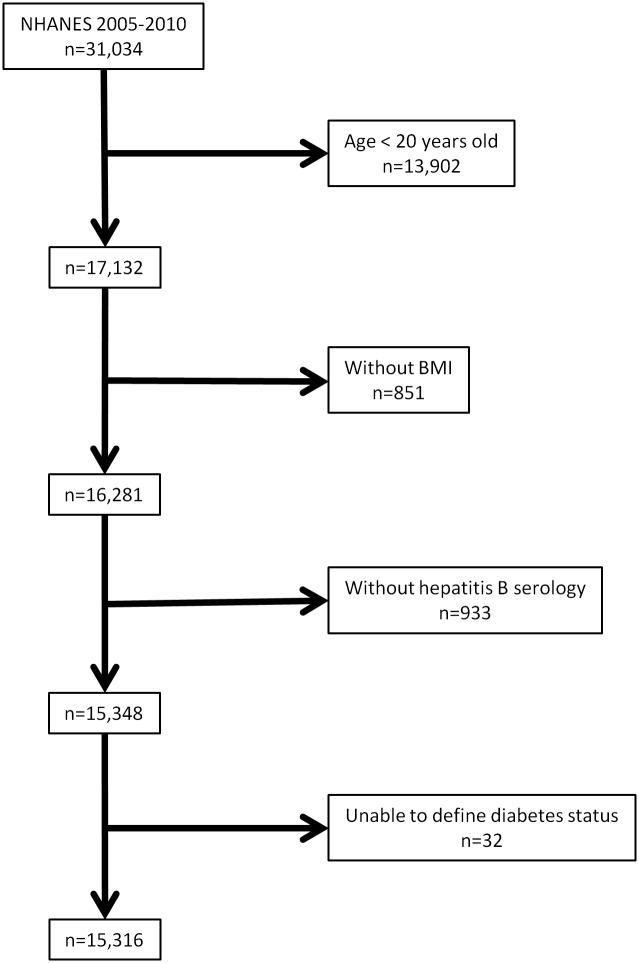
Sampling scheme.